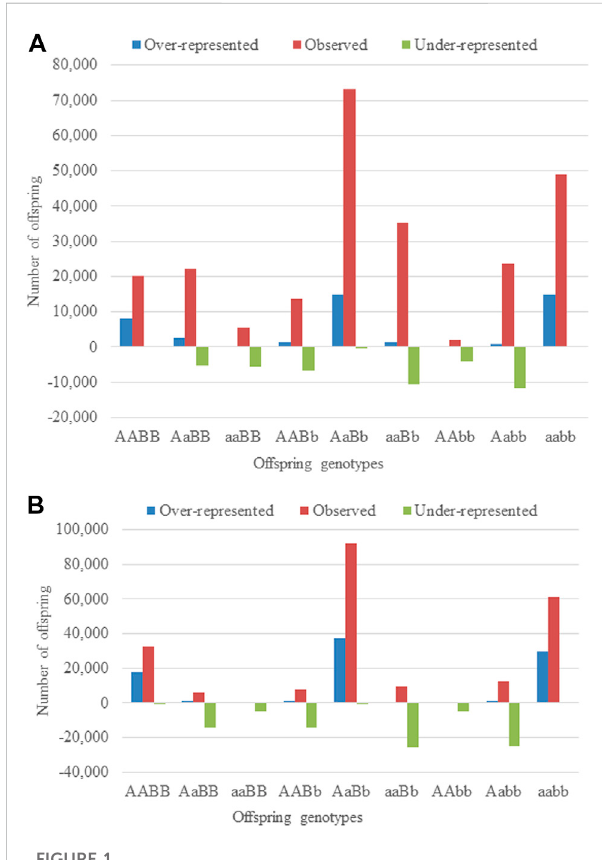
FIGURE 1 The observed, under- and over-represented offspring across matings in two-locus genotype with (A) additive-by-additive and (B) dominance-by-dominance epistatic